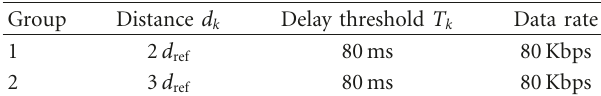
Table 1: First scenario